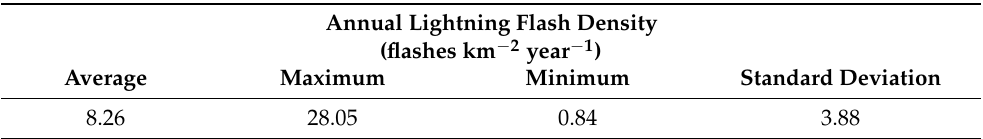
Table A3. Statistics of the annual lightning flash density, based on the 1998–2014 LIS Data from the TRMM Satellite.